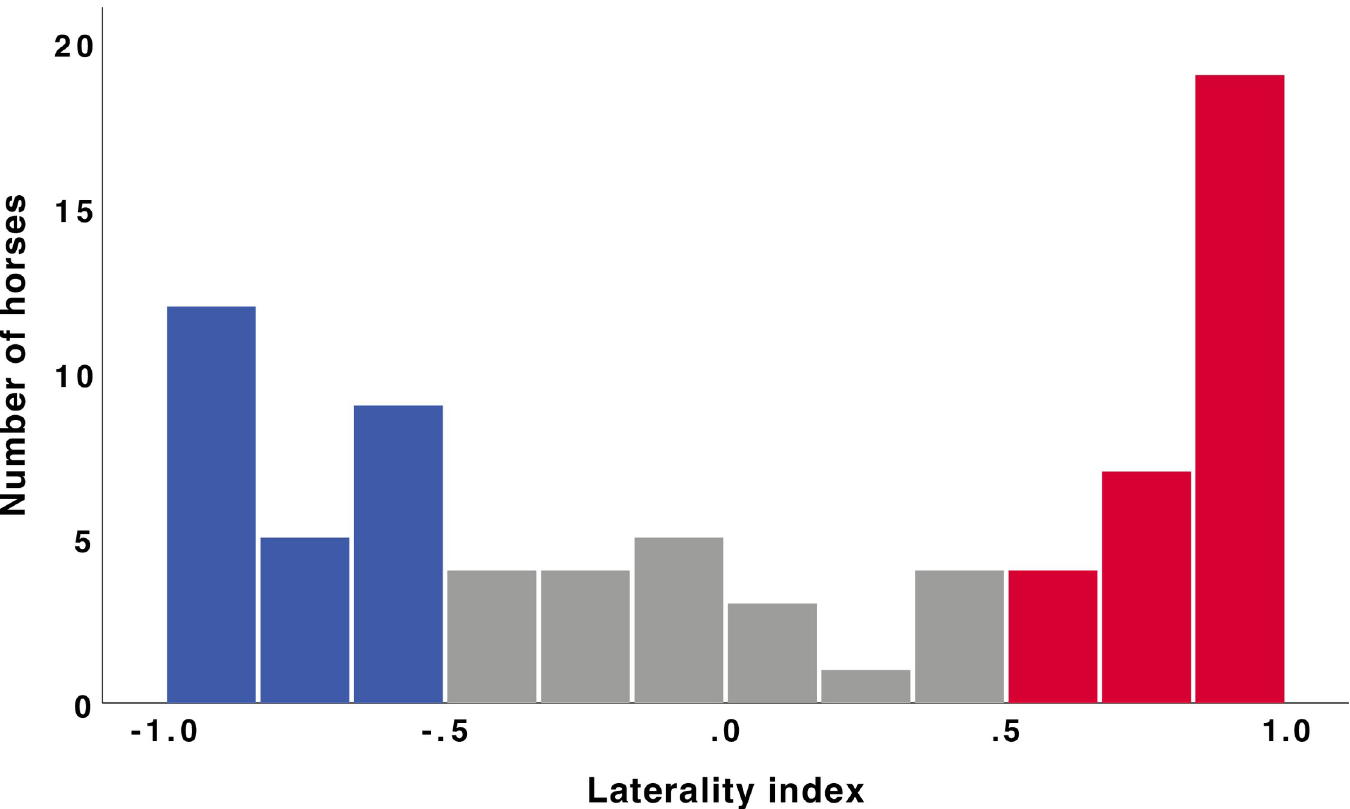
Fig 2. The laterality index of each horse while inspecting the balloon stimulus with one eye. A laterality index of > 0.5 indicates a right eye preference (shaded in red) while laterality index < -0.5 indicates a left eye preference (shaded in blue). Horses that showed a weak or absent preference for one eye over the other are shaded in grey. The number of horses showing left and right eye preferences did not differ (p =